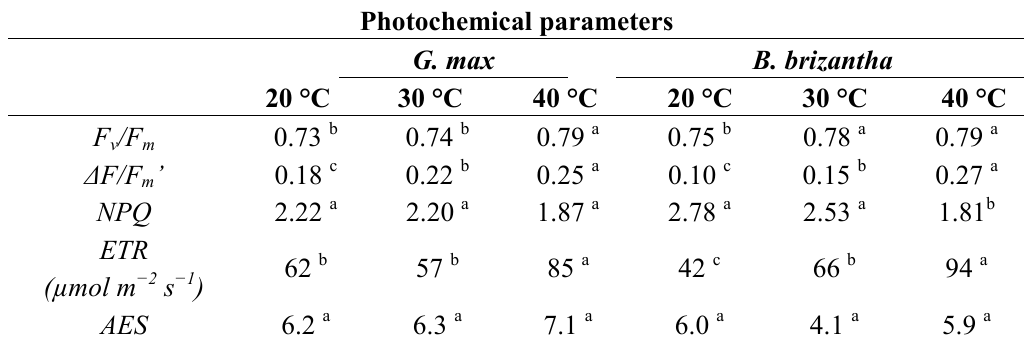
Different letters indicate statistical difference ( p < 0.05) between temperature conditions to each